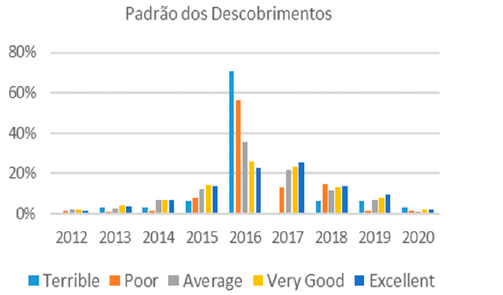
Figure 8. Normalized percentage of ratings offered in each case of study.